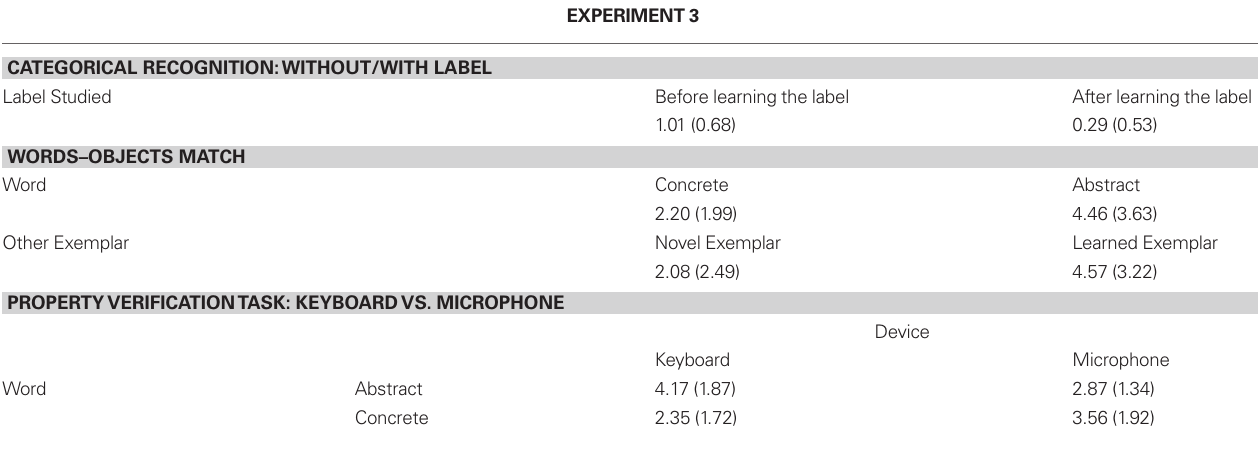
Table 3 | errors percentages and standard deviations (in parenthesis) for each TeST of experiment